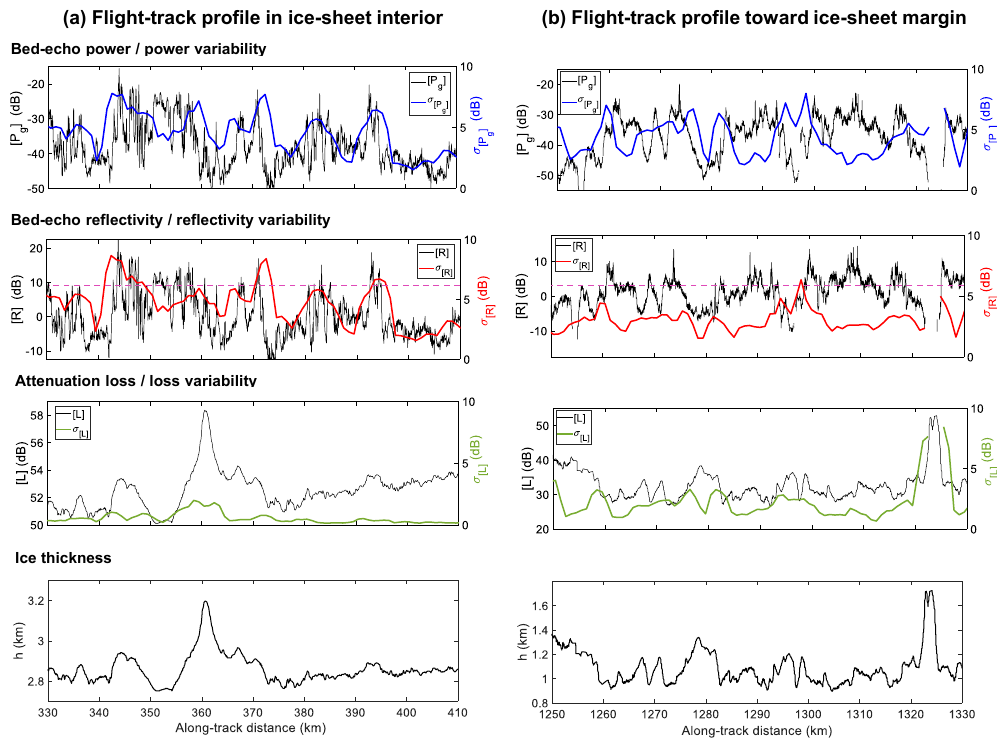
Figure 2. Example flight-track profiles for bed-echo power and variability, [ P g ] and σ [ P , bed-echo reflectivity and variability, [ R ] and σ [ R ] , g ] attenuation loss and variability, [ L ] , σ [ L ] and ice thickness, h . Example (a) , left panel, is from the north-central interior of the ice sheet and (b) , right panel, is from the north-western margins (locations both shown in Fig. 3). The threshold that is later used for water detection, σ [ R ] > 6dB, is indicated by the dashed pink line and applies to the right axis. The values for [ R ] are relative with zero mean. The variability measures are all calculated at a 5km length scale with 1km